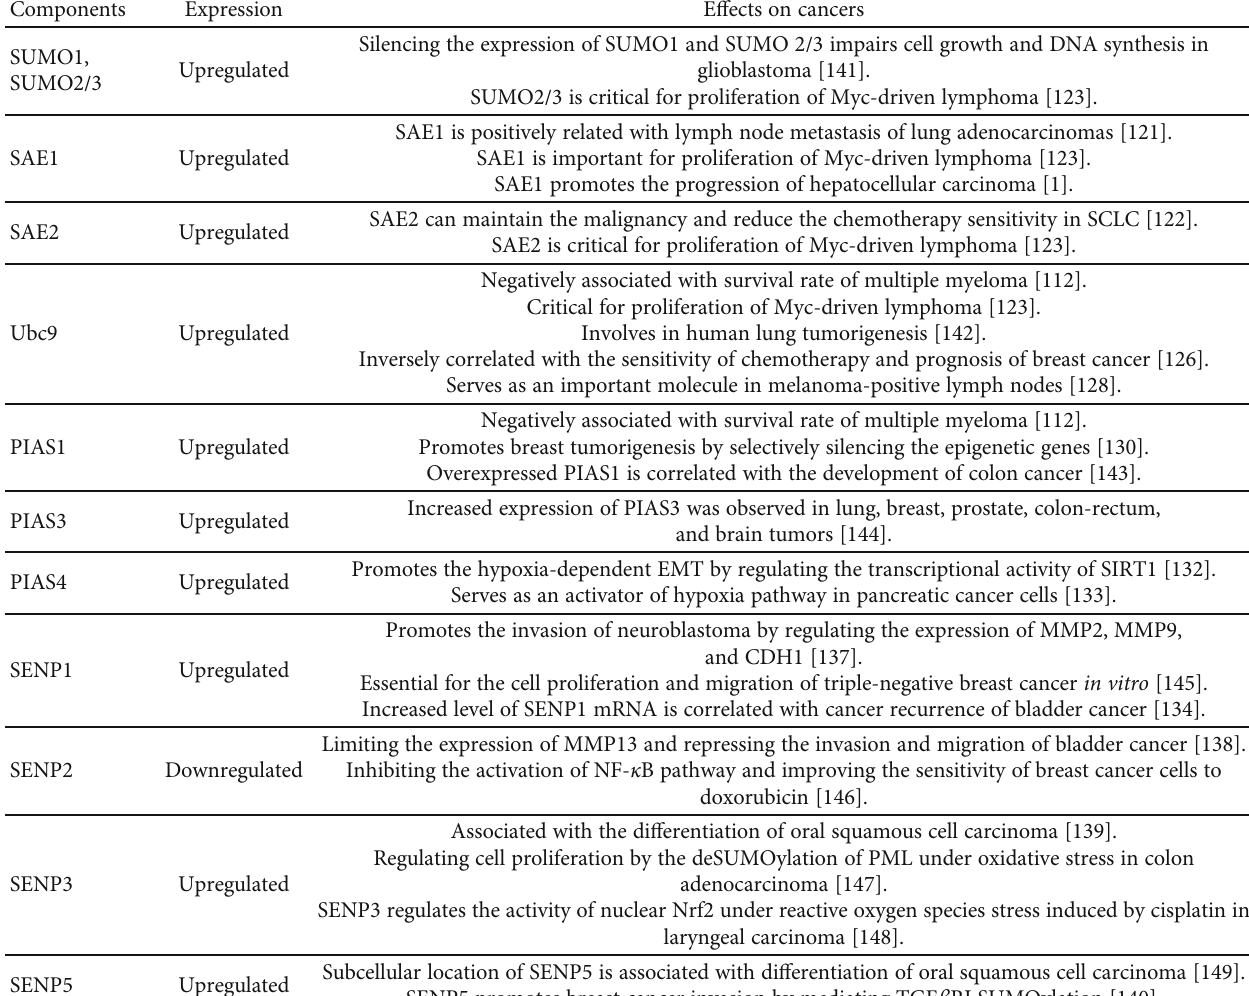
Table 2: SUMOylation in di ff erent kinds of cancers.